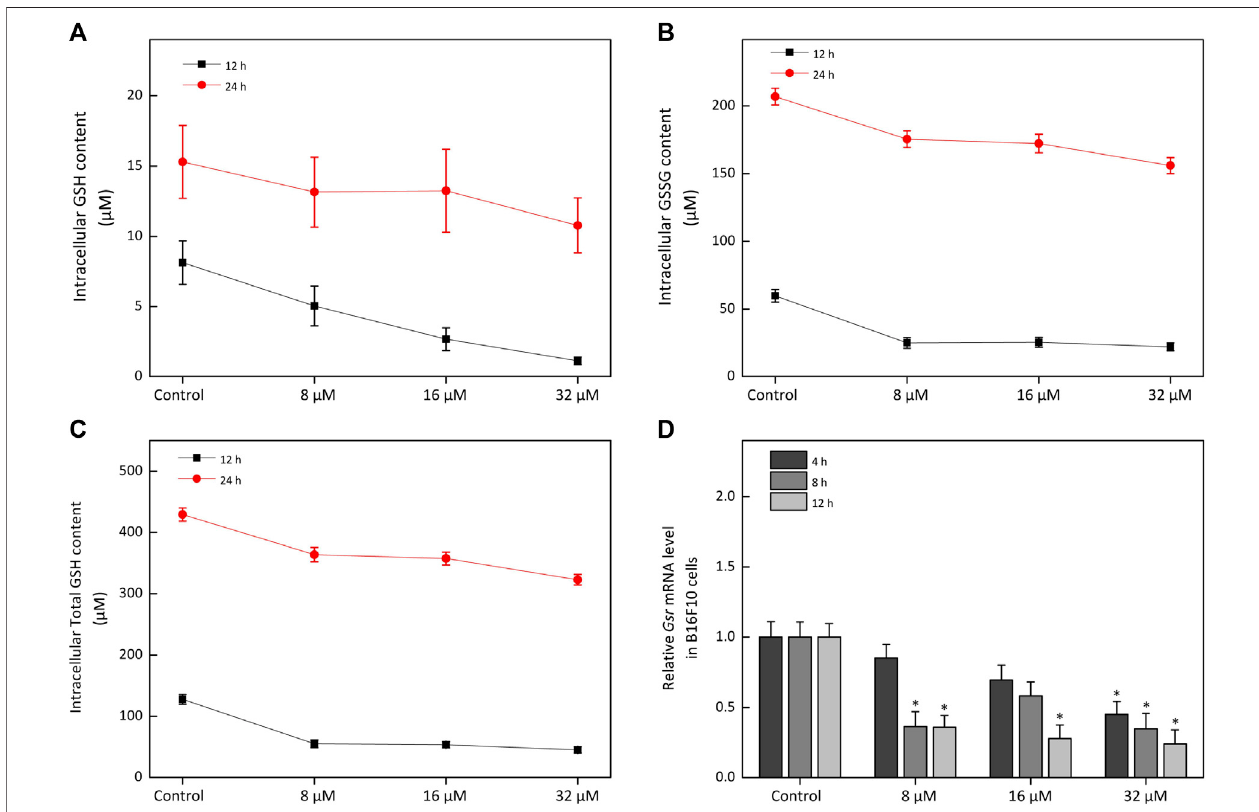
FIGURE 9 | The effect of kaempferide on the glutathione metabolism in B16F10 cells. (A – C) The concentration of GSH, GSSG and total GSH after kaempferide treatment (8, 16 and 32 μ M) in B16F10 cells for 12 and 24 h. C total GSH (cid:1) C GSH + 2 C GSSG , C represented concentration. (D) The relative expression levels to Gsr mRNA after kaempferide treatment (8, 16 and 32 μ M) in B16F10 cells for 4, 8 and 12 h.